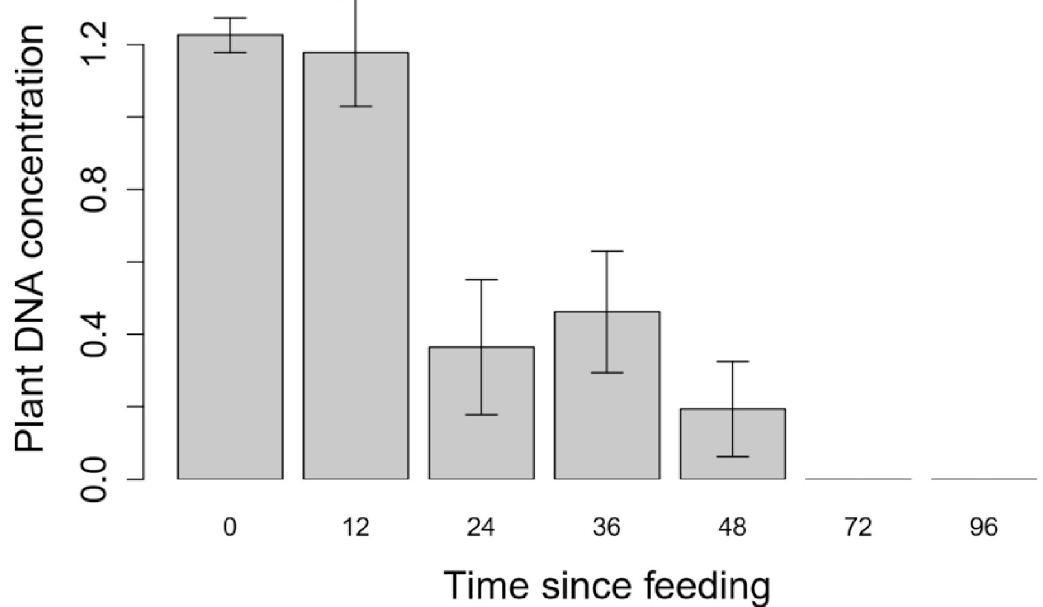
Fig 3. The concentration of remaining plant DNA ± SE in the gut of Melanoplus ponderosus after feeding at intervals of 0, 12, 24, 36, 48, 72- and 96-hours post-feeding, using the multiplex primer mix. R statistical software was used to create this